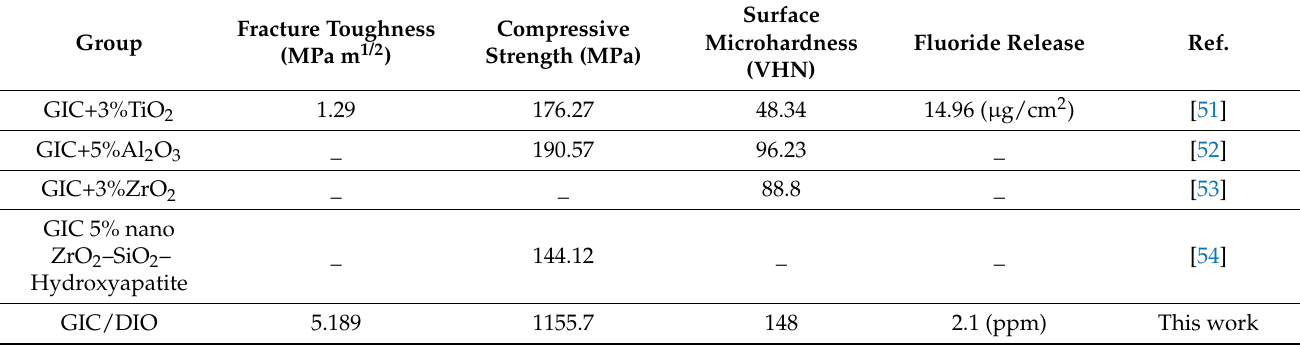
Table 2. Comparison of data with other